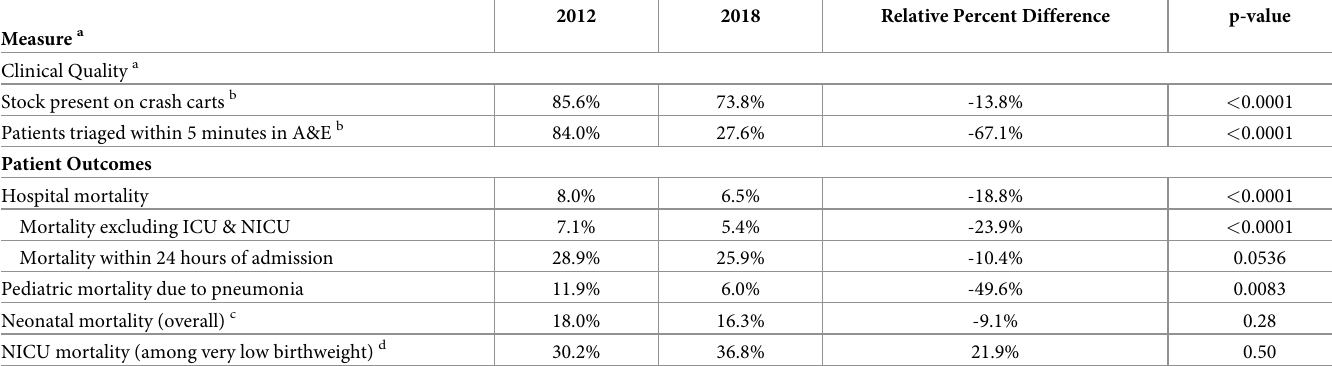
Table 3. Clinical Quality and Patient Outcome Measures at Queen ‘Mamohato Memorial Hospital Integrated Network Managed by a Public-Private Partnership in 2012 and